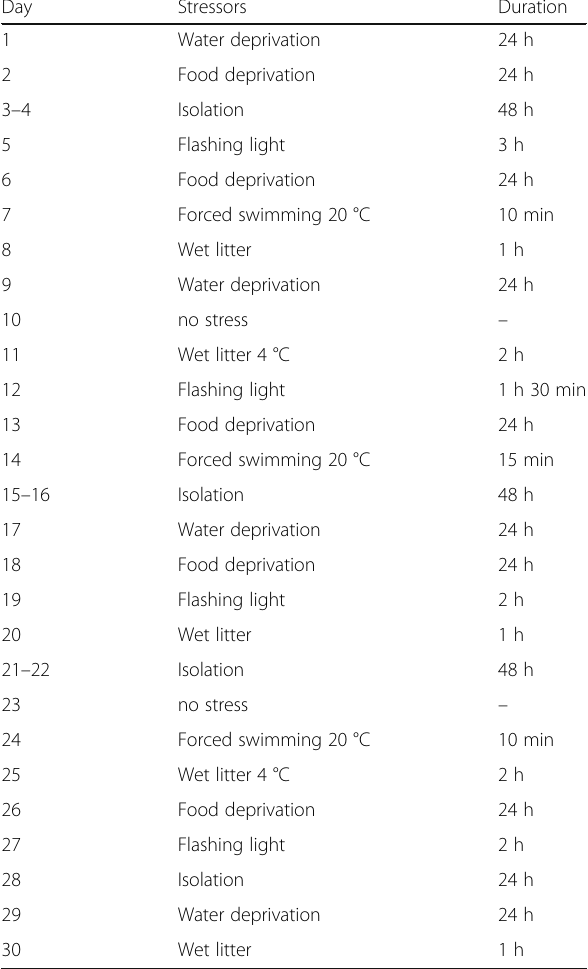
Table 1 Program of stressors and duration applied every day. During all these days the saline solution, plant extract or imipramine were administrated depending on the